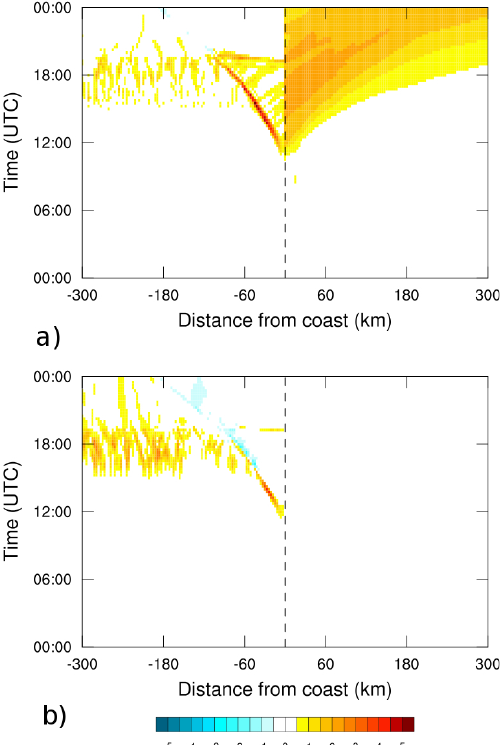
Fig. 18. Differences in u-wind speed between two single coast simu- lations using alternative initial profiles. Results based on 00:00UTC profiles for 4 June 2006 (Fig. 4) subtracted from the results for (a) 3 and (b) 2 June 2006. In all cases, the YSU PBL and an SST of 287K were